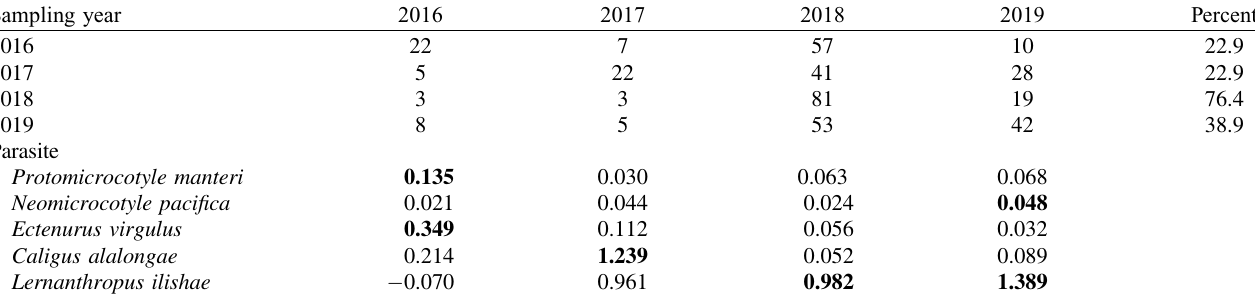
Table 4. Discriminant analysis classi fi cation showing the numbers and percentages of the Caranx sexfasciatus classi fi ed in each sampling year (rows correspond to group memberships). The bottom of the table shows the matrix of classi fi cation coef fi cient values for parasites that allowed differentiation among sampling years; coef fi cient values in bold indicate the importance of each species of parasite in distinguishing among